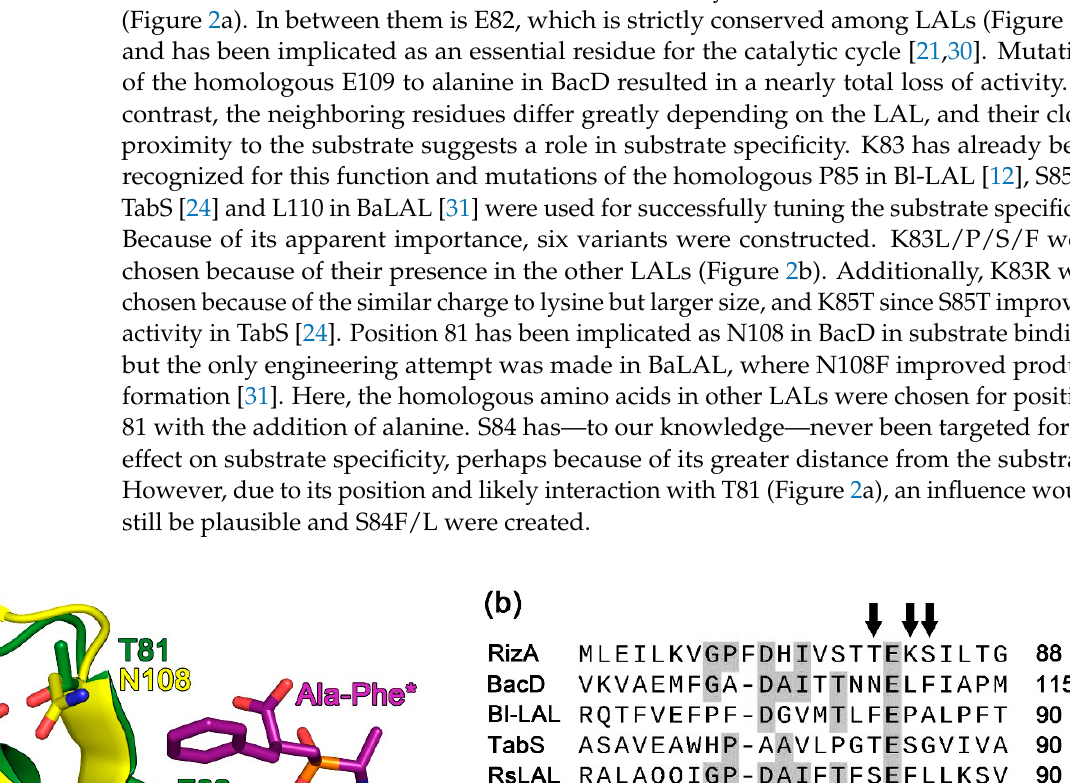
Figure 1. Mutated residues of RizA (green) in the C-(red) and N-terminal (blue) binding pocket (PDB ID: 4wd3). The structure contains the phosphorylated phospino-analog of L -Ala- L -Phe (pur- ple) from the structural alignment with BacD (PDB ID: 3vmm). Structures were displayed using PyMOL [29] .